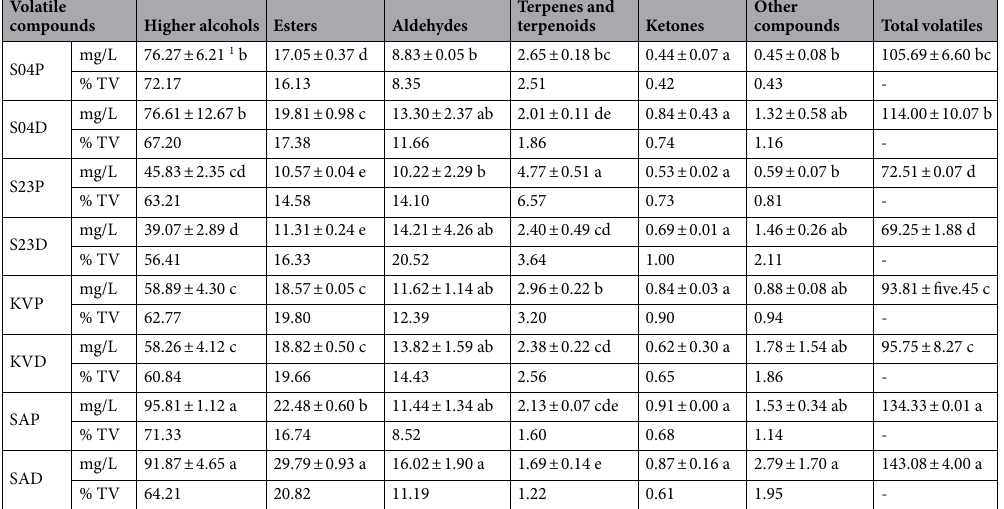
Table 1. Total contents and percentage share of groups of volatile compounds in beers. 1 Values are expressed as mean (n = 2) ± standard deviation. The mean values with different letters (a, b, c, d, e, f) within the same column are statistically different ( P < 0.05). S04P—pale beer fermented by Saccharomyces cerevisiae S04 yeast strain, SO4D—dark beer fermented by Saccharomyces cerevisiae S04 yeast strain, S23P -pale beer fermented by Saccharomyces pastorianus S23 yeast strain, S23D—dark beer fermented by Saccharomyces pastorianus